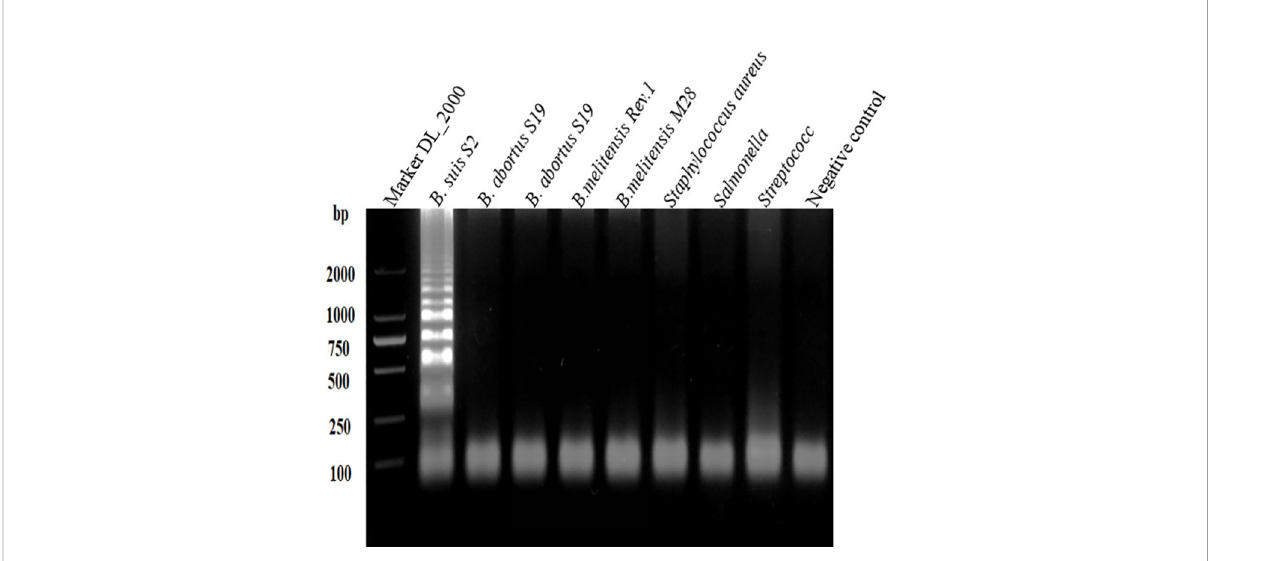
FIGURE 3 Target speci fi city of the L-\MP assay. Assay products were visualized using gel electrophoresis. Cross reaction was not observed when 10 ng/µL of DNA from B. suis S2, B. abortus SI9, B. abortus A19, B.melitensis Rev.1, B.melitensis M28 strains, Staphylococcus aureus, Salmonella, Streptococcus DNA and negative control were